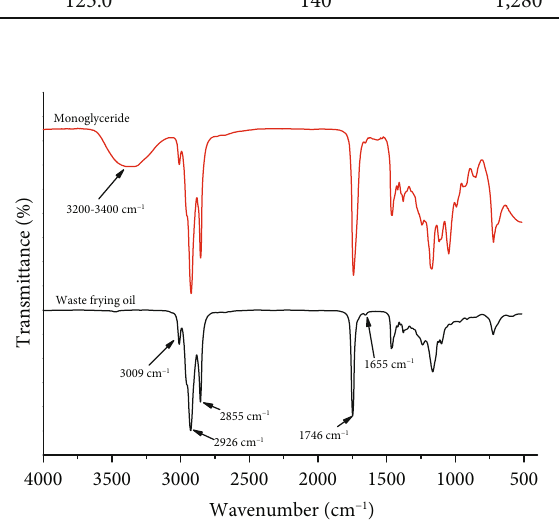
Figure 1: FT-IR spectra of waste frying oil and the as-prepared